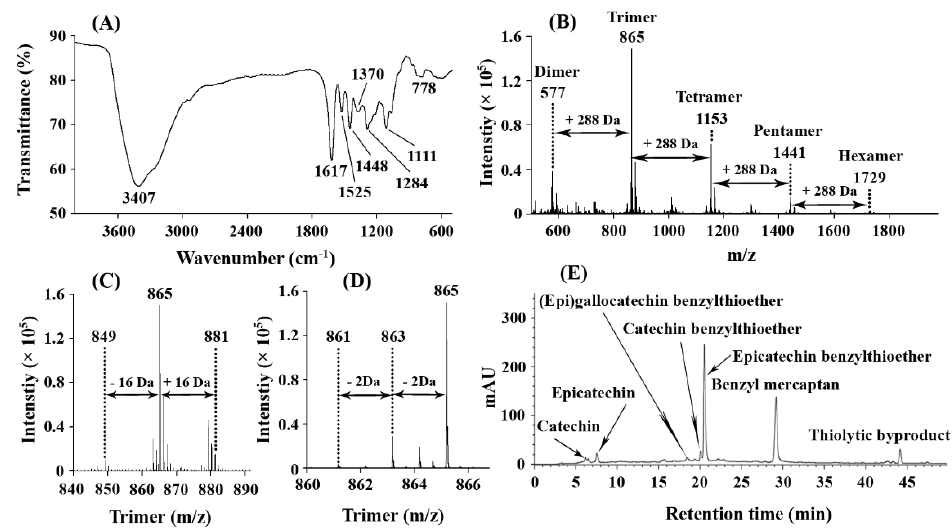
Figure 3. ( A ) FT-IR spectrum of ASBPs; ( B ) Negative-ion ESI-MS spectrum of ASBPs; ( C , D ) Amplified spectra of the trimer; ( E ) Reversed-phase HPLC chromatogram of thiolytic products of